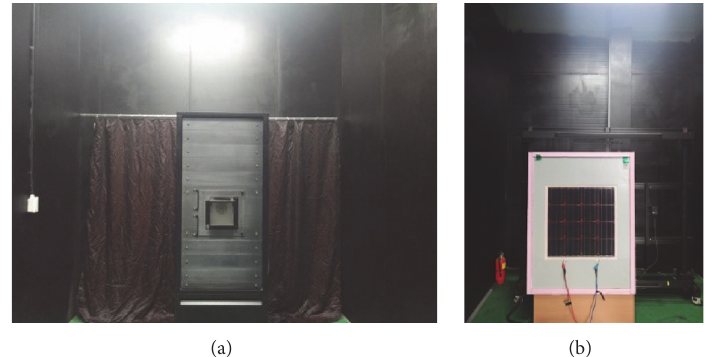
Figure 9: Photograph of the flash unit (a) and the bifacial BIPV module set-up (b) in the sun simulator test room.